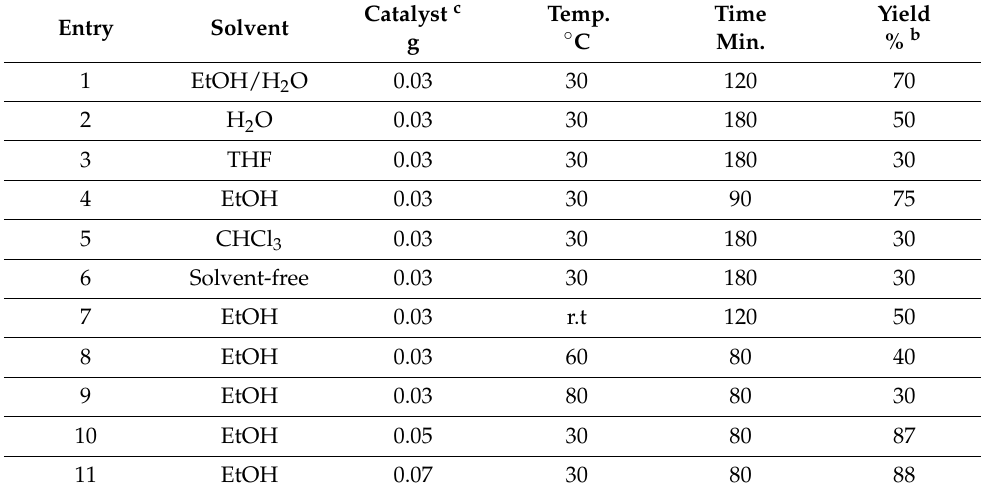
Table 5. Optimization of the three-component reaction of 3-methyl-1-phenyl-1 H -pyrazol-5-ol, ben- zaldehyde, and indole a